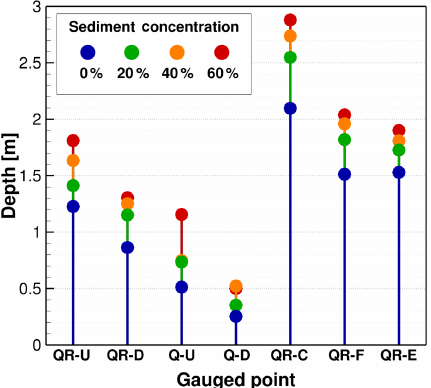
Figure 10. Maximum depth computed at every gauged point de- pending on the sediment concentration.